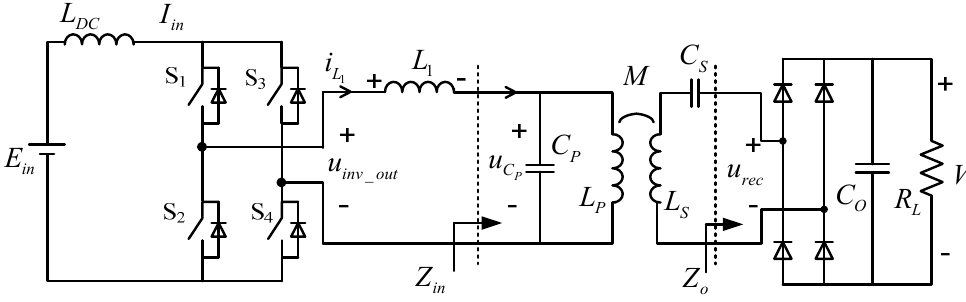
Figure 13. Circuit of the experimental system (with series resonant network in secondary side).